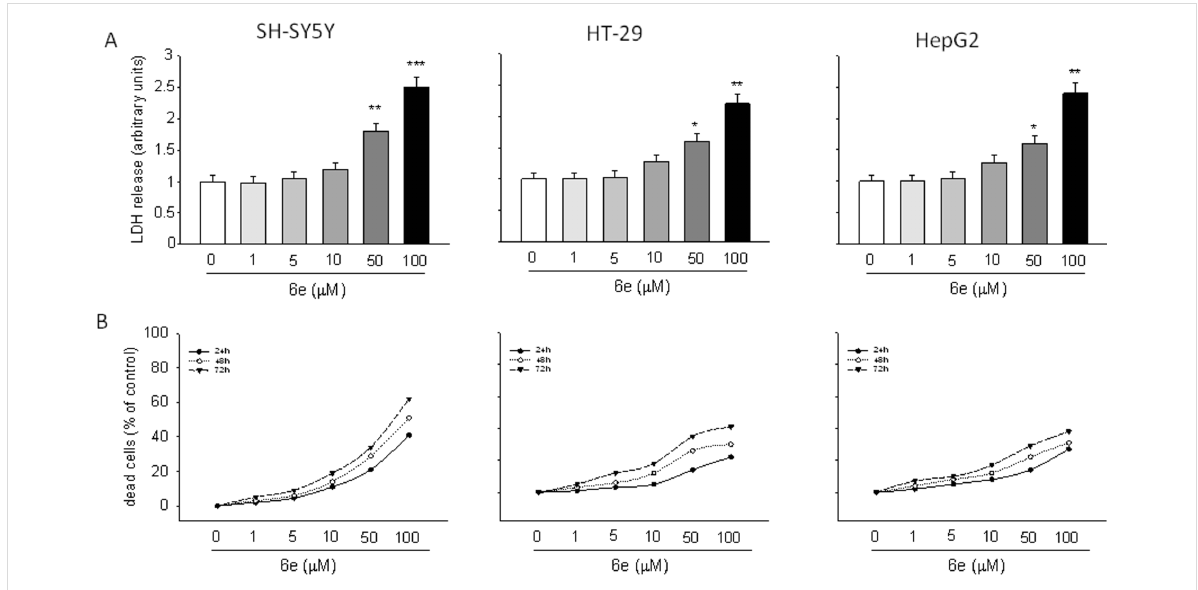
Figure 8: Cytotoxic effect of 6e . The cytotoxic activity of 6e was assessed in terms of both LDH release (a) and cell death (b). LDH levels are extrapo- lated as the values detected in untreated cells, which are arbitrarily expressed as 1. Cell death was reported as the percentage of dead cells vs untreated cultures point to 0. Data, expressed as mean ± S.E.M., represent the values obtained in three different sets of experiments made in tripli- cate. * P < 0.05, ** P < 0.01 and *** P < 0.001 vs untreated cells.